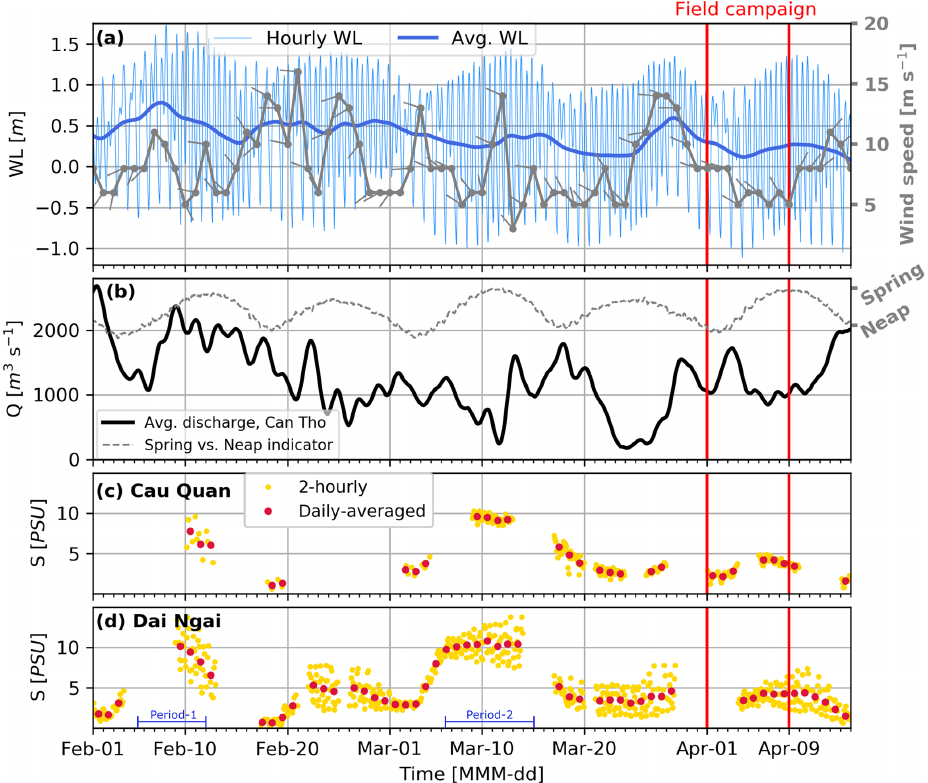
Figure 3. Water level at Can Tho (80km from the estuary mouth) and offshore ocean wind speed and direction (nautical convention, from the vectors ) (a) , observed subtidal discharge at Can Tho and the daily semi-diurnal tidal amplitude as an indication of spring–neap cycle (b) , and stationary salinity measurements in the lower distributary channels of the Hau River, Dinh An channel (c) , and Tran De channel (d) prior to and during the field